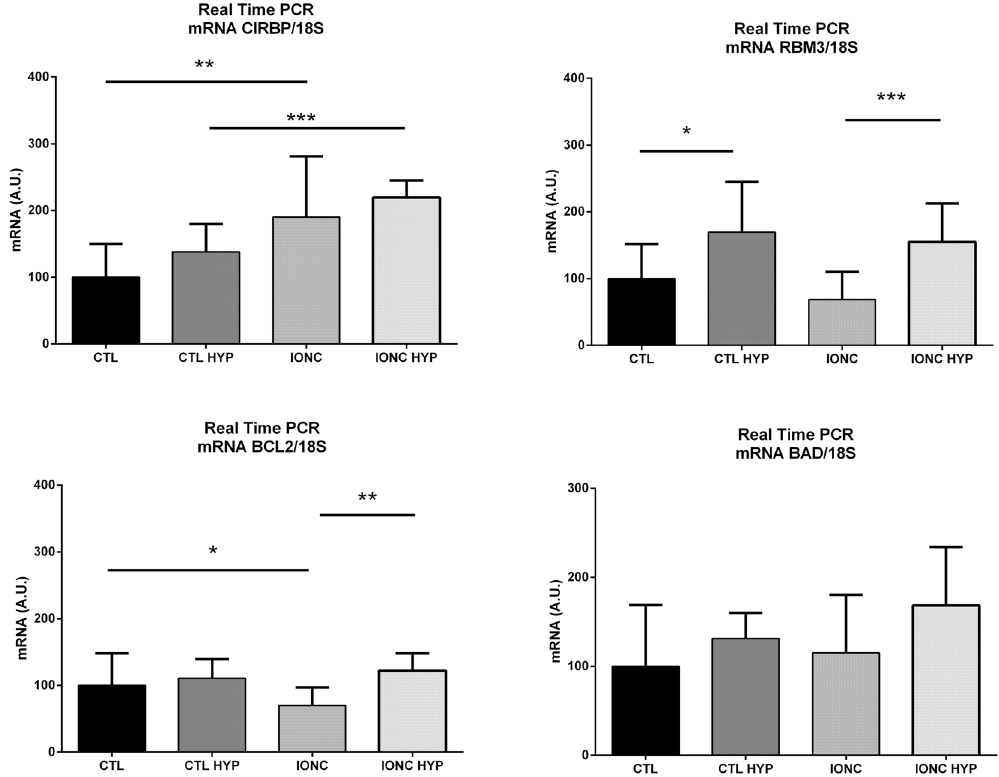
Figure 7. Relative gene expression for CIRP ( A ), RBM3 ( B ), BCL2 ( C ), and BAD ( D ) in the 4 experimental groups, as measured by qRT-PCR. All values were normalized using the house-keeping gene 18S. Bars represent the mean ± SD of all samples (n = 6 per group). Asterisks represent statistically significant differences, as indicated. * p < 0.05; ** p < 0.01; *** p <